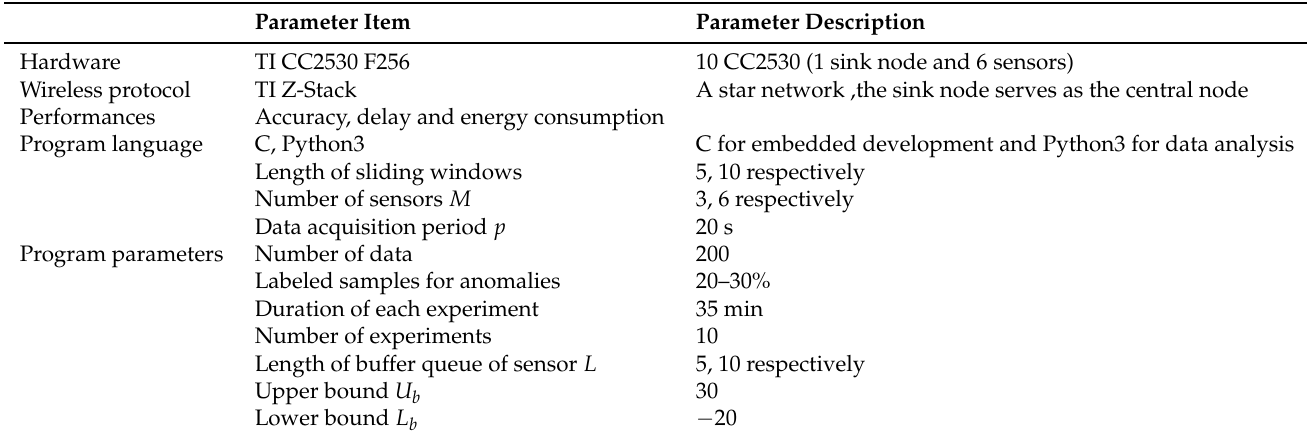
Table 2. This is a table caption. Tables should be placed in the main text near to the first time they are cited.